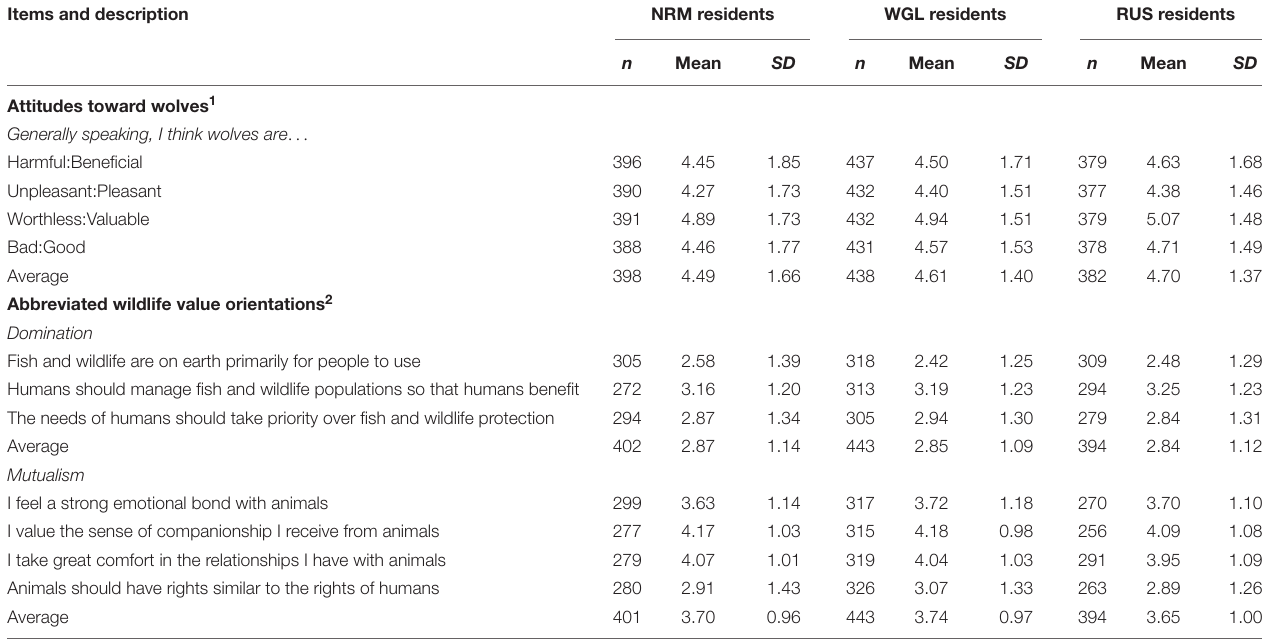
TABLE A1 | Descriptive statistics of indices and items used to measure model variables by region in the United States (2014). Items and